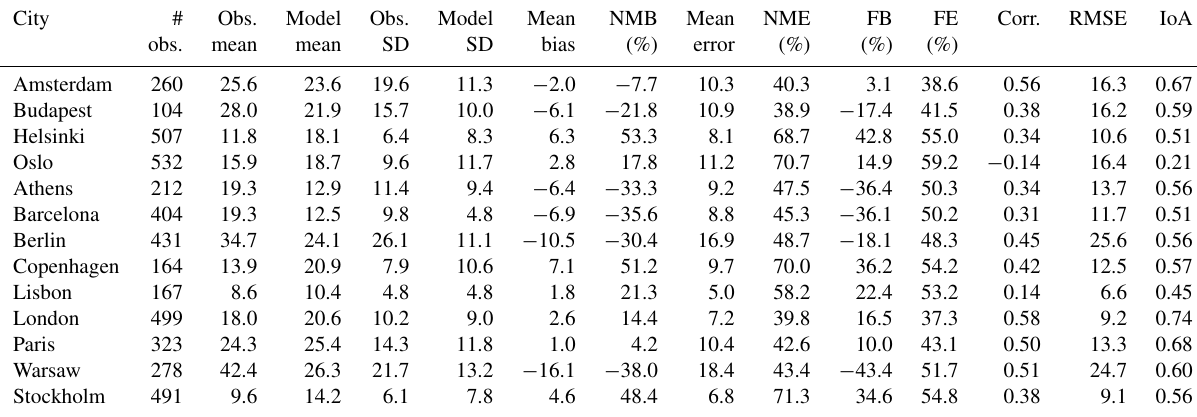
Figure 4. Evaluation of CAMx model performance for PM 2 . 5 at selected cities for July 1 to September 30, 2010. (a) Comparison of the observed (black) and modeled (red) seasonal mean concentrations. Bars show the corresponding observed (grey) and modeled (orange) standard deviation. (b) The seasonal fractional bias (orange), fractional error (red), and correlation (green) computed for each city. Table 5. Summary of CAMx model performance evaluated at background AirBase sites belonging to the selected cities. Statistics are computed for daily mean PM 2 . 5 concentrations over the winter season (1 January–31 March). City #